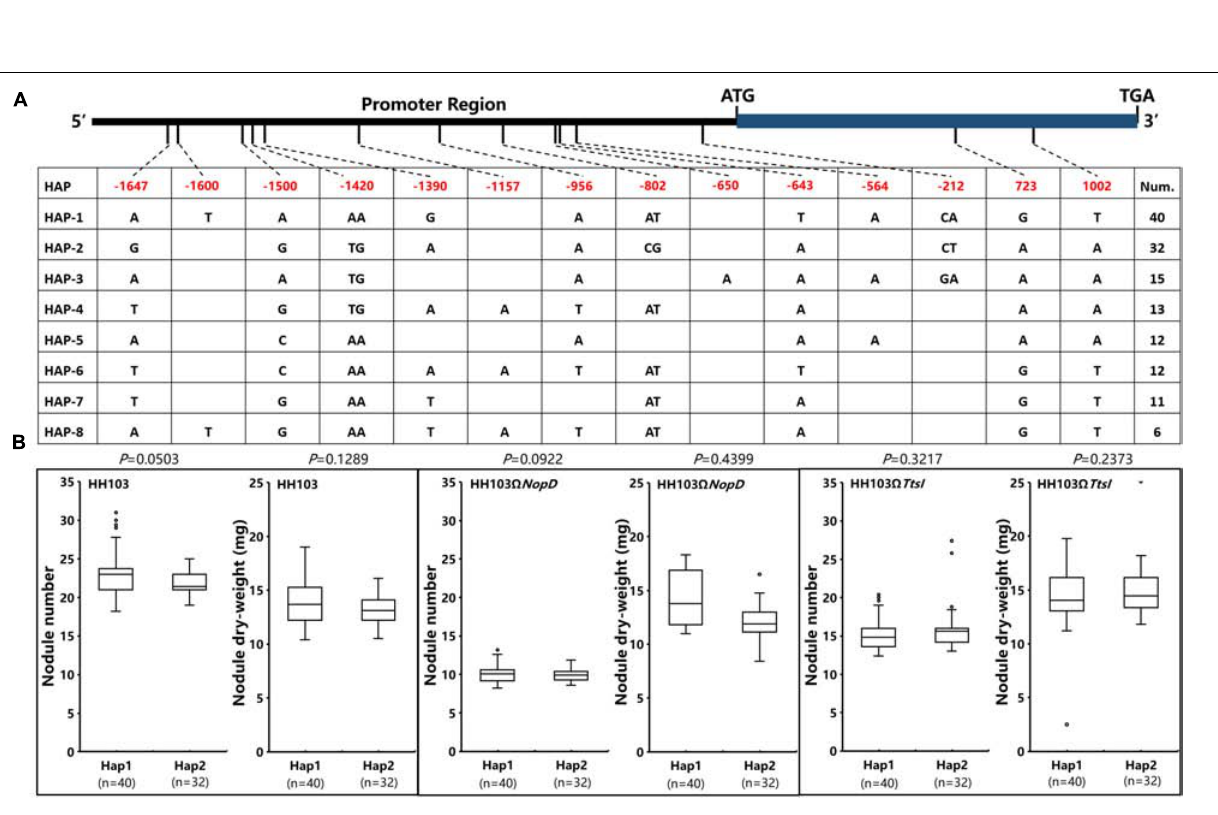
Frontiers in Plant Science |